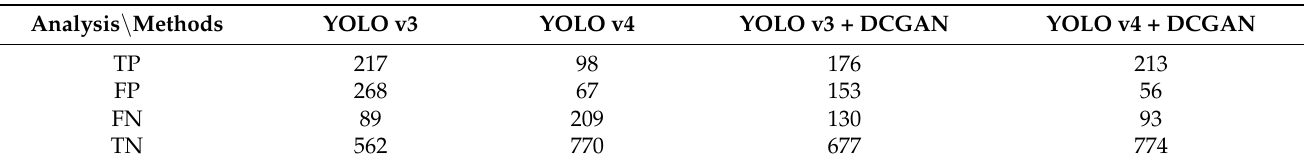
Table 3. Model prediction data.